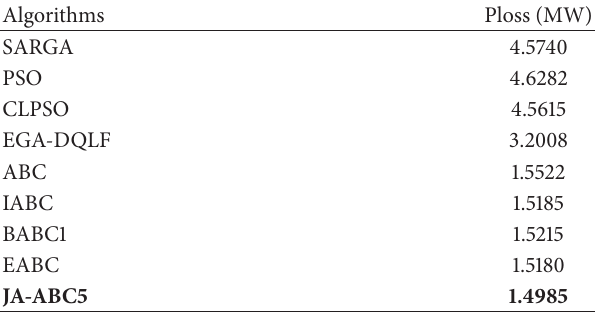
Table 3: Performance of optimization algorithms in solving RPO.